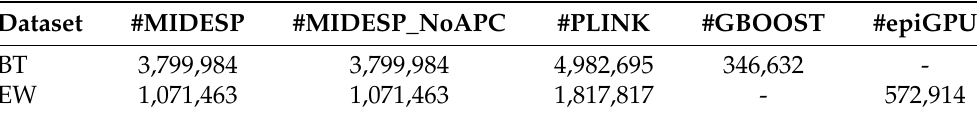
Table 2. Number of SNP pairs that were found to be an epistatic interaction by the different methods. BT and EW stand for bovine tuberculosis and egg weight, respectively.